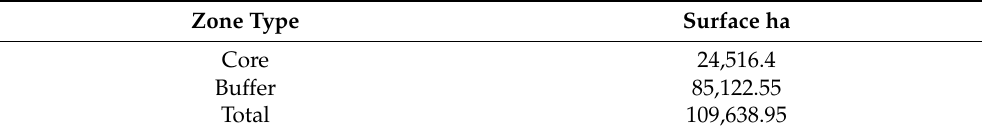
Table 5. Surface of the core and buffer zones of the Protected Natural Area Sierra de San Miguelito, San Luis